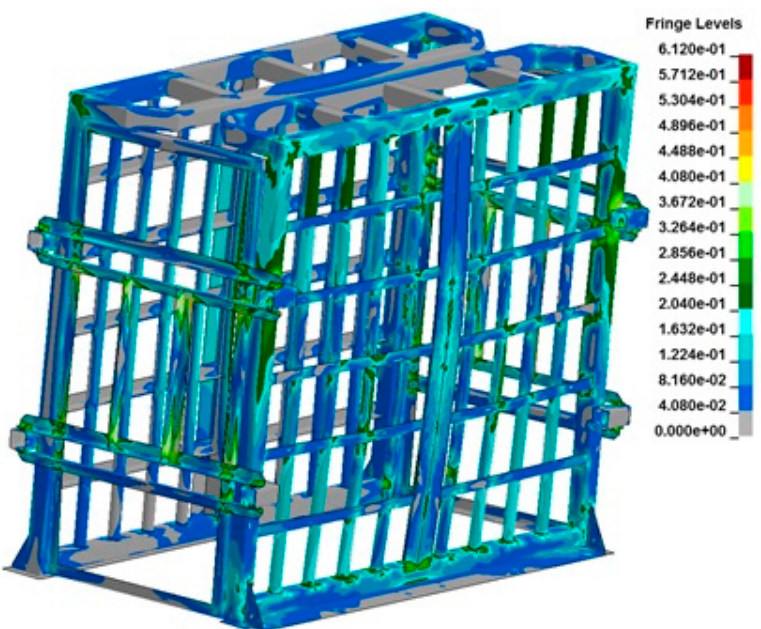
Figure 12. Reduced stress for the maximum displacement value of a cage center impact [GPa] calculated using the Huber–Mieses–Hencky hypothesis.